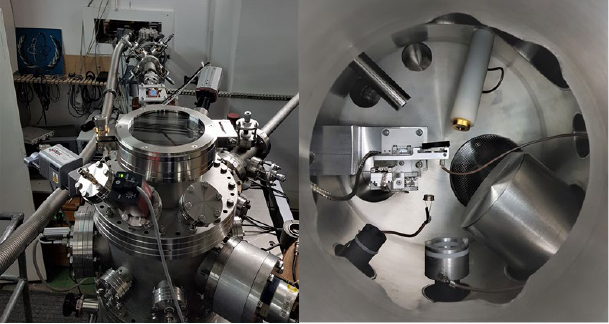
Fig. 5. IAEA dual beam experiment at